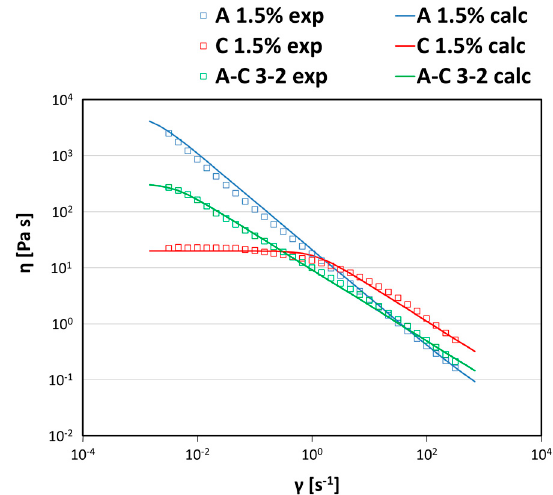
Figure 5. Viscosity curves as a function of the shear rate for the samples prepared with A, C, and the A–C association (3:2) at the same total polymer amount (1.5% w/w). Flow curves (exp) were fitted with the Carreau − Yasuda model (calc).